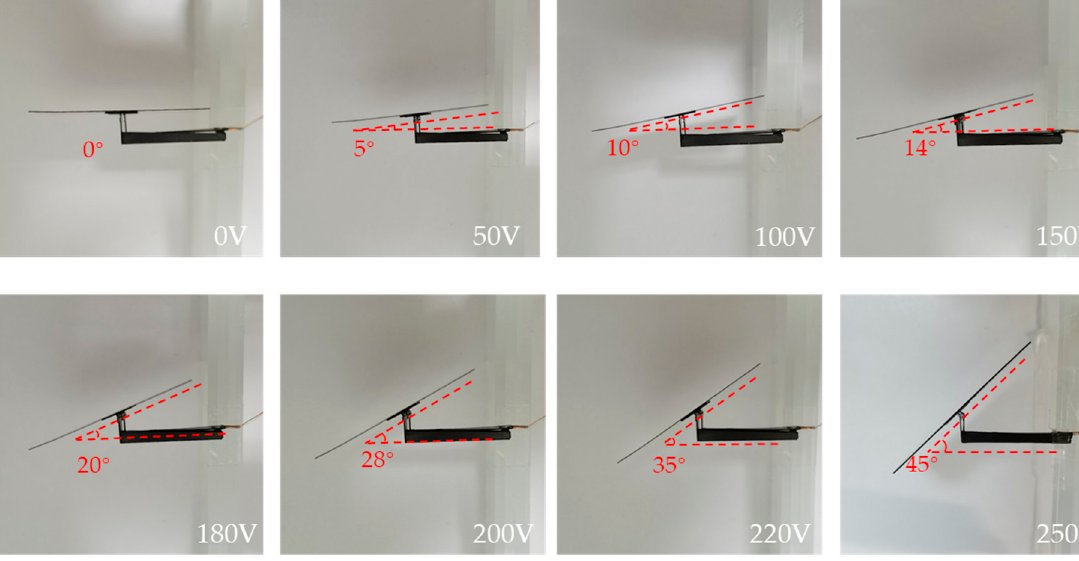
Figure 8. Forward-bias drive test of deformed squama. Table 2. Actual scale angles corresponding to given forward-bias driving voltages.